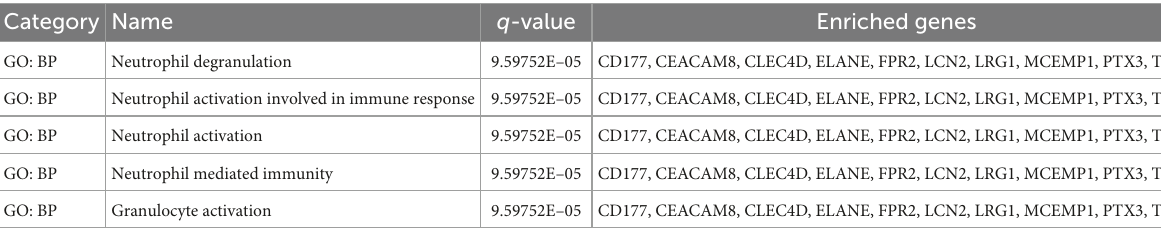
TABLE 2 The top five GO items enriched by hub genes, GO (gene